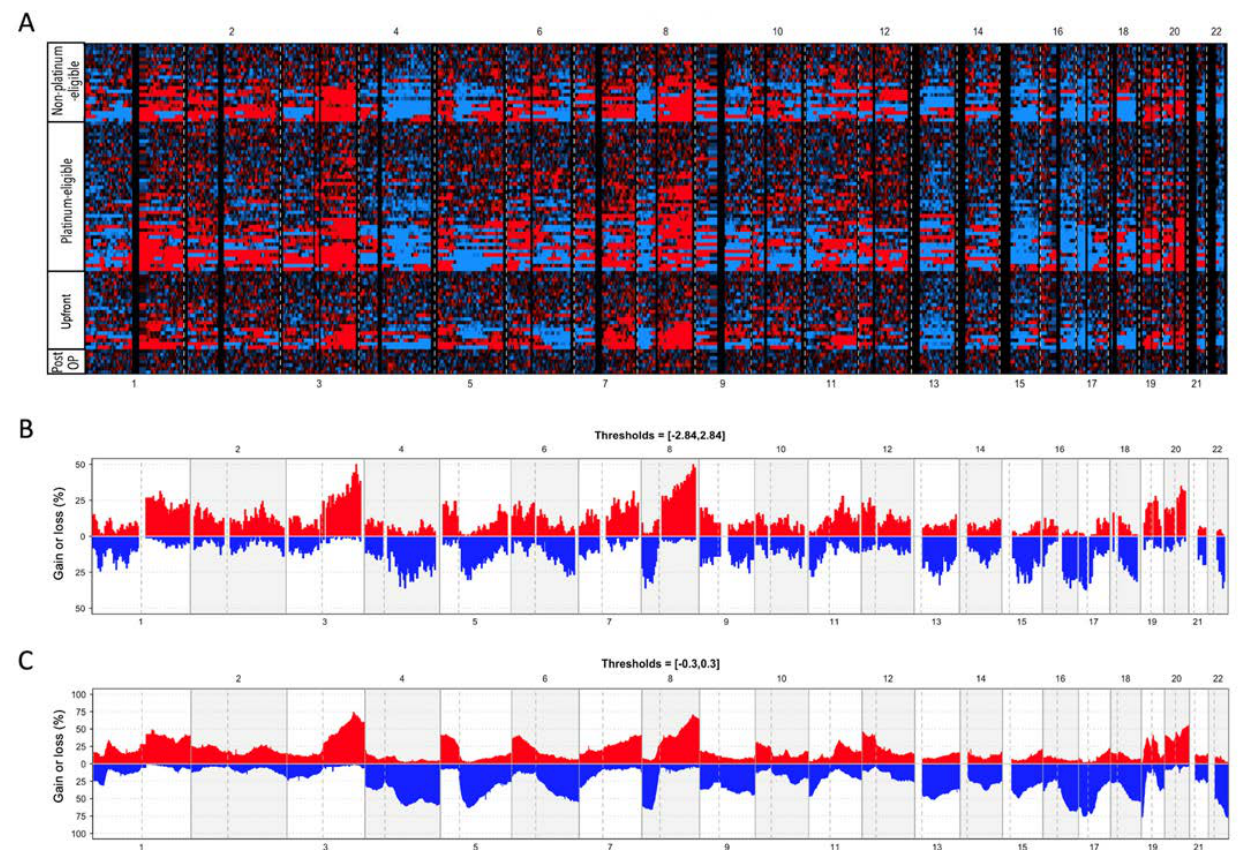
Figure 3. A : Heatmap image displaying the genomic bins with significantly altered copy numbers in the different groups of cancer patients (cut-offs: Z-scores > 2.84 (red), Z-scores < − 2.84 (blue)). B : Frequencies of copy number changes detected in the plasma of patients bearing primary or recurrent tumors. C : Frequencies of gains and losses in tumor tissue data obtained from the TCGA